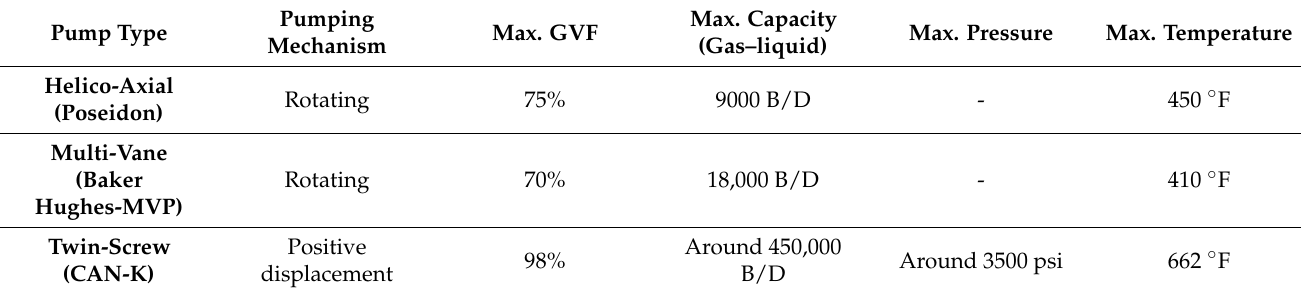
Table 8. Present gas-handling technologies for pumping gas–liquid mixtures and important features. Pump Type